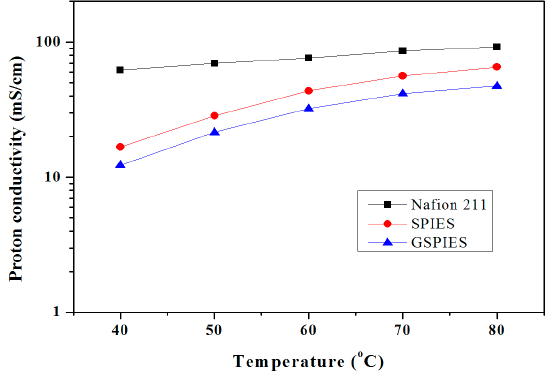
Figure 7. Proton conductivity of membranes at 40–80 °C under 80% RH.